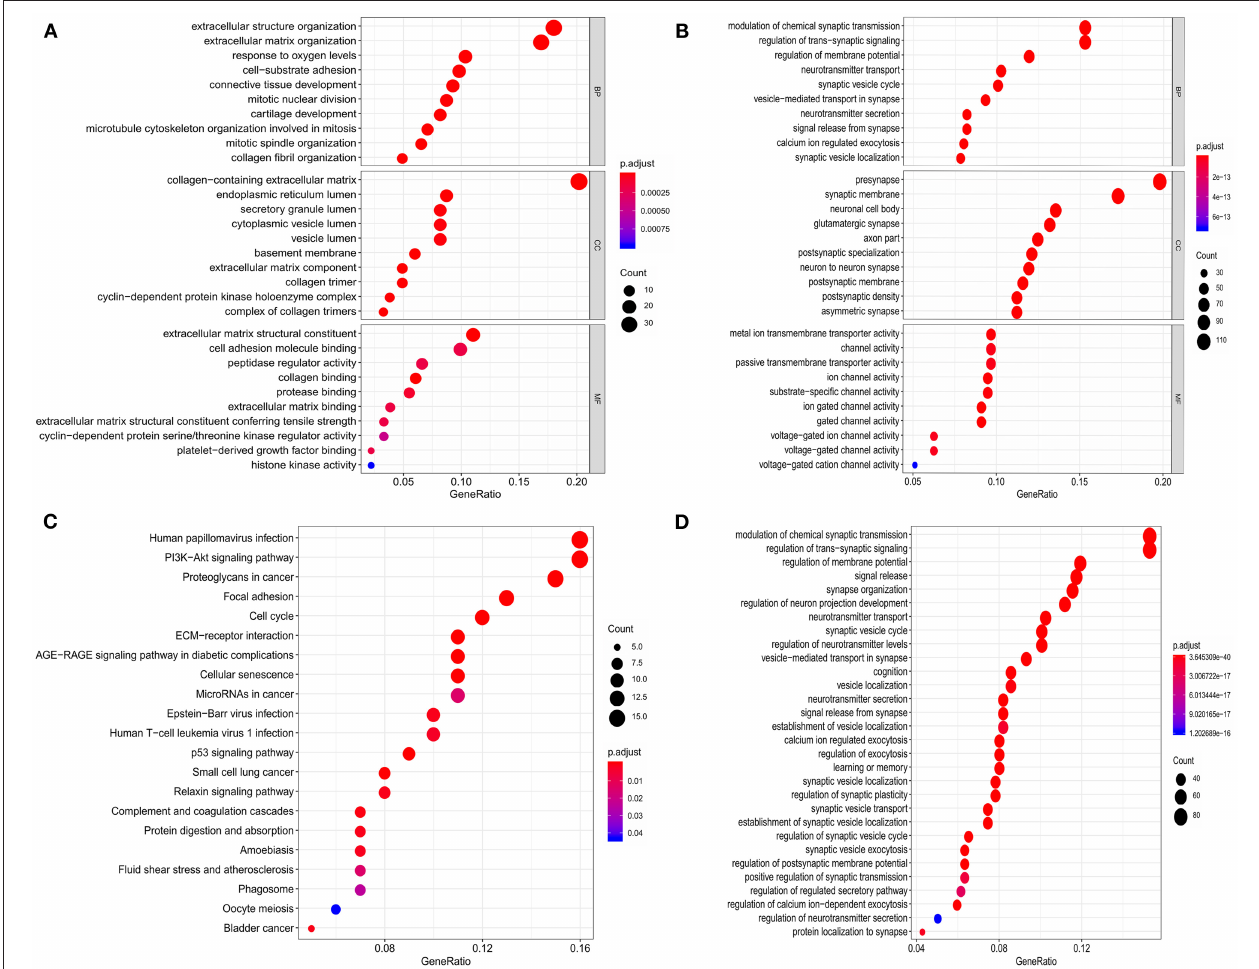
FIGURE 2 | Functional enrichment analysis of the DEGs. (A,B) GO enrichment analysis of the upregulated and downregulated DEGs, respectively. (C,D) KEGG pathway enrichment analysis of the upregulated and downregulated DEGs,